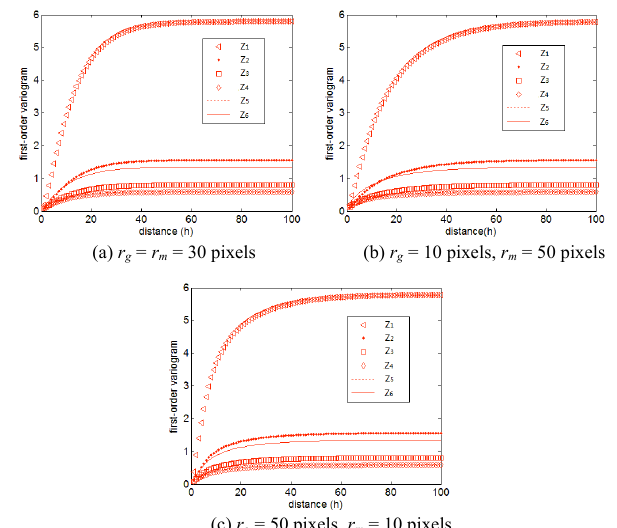
(c) r g = 50 pixels, r m = 10 Fig.4 Experimental first-order variograms computed over images simulated from the random functions Z i ( x ), i =1,..., 7.